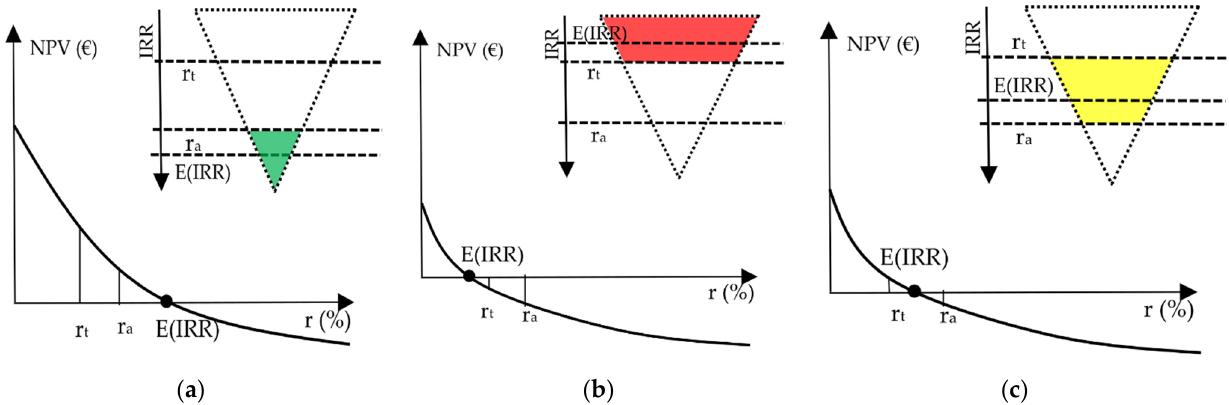
Figure 6. Acceptability and tolerability of the investment in terms of E(IRR) ( a ) Widely acceptable condition; ( b ) Unacceptable condition; ( c ) Tolerable condition according to the ALARP principle.